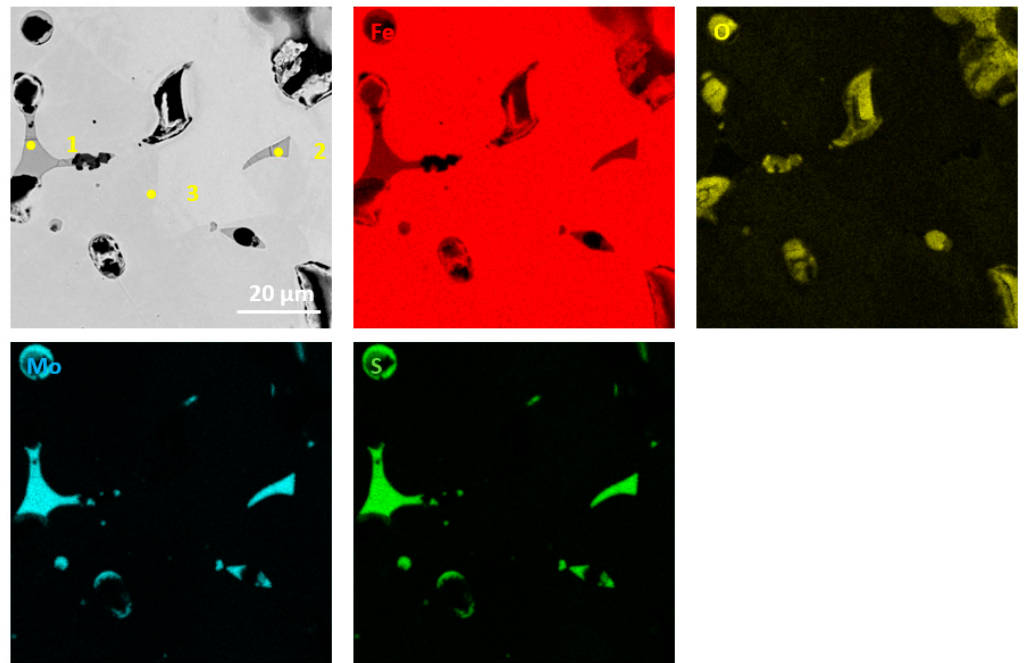
Figure 11. EDS mapping of sintered Fe with the addition of MoS 2 with a size of 1.5 µ m (for pressing pressure 350 MPa).